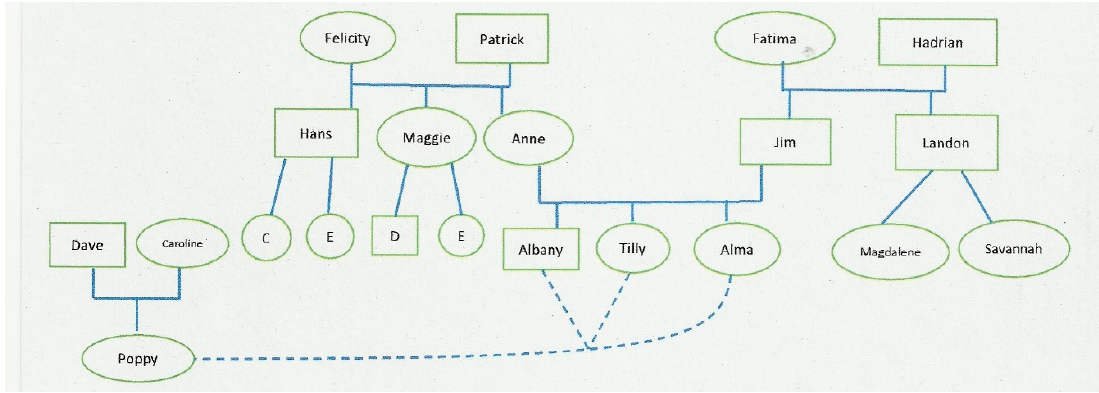
Figure 4. Anne’s family map.